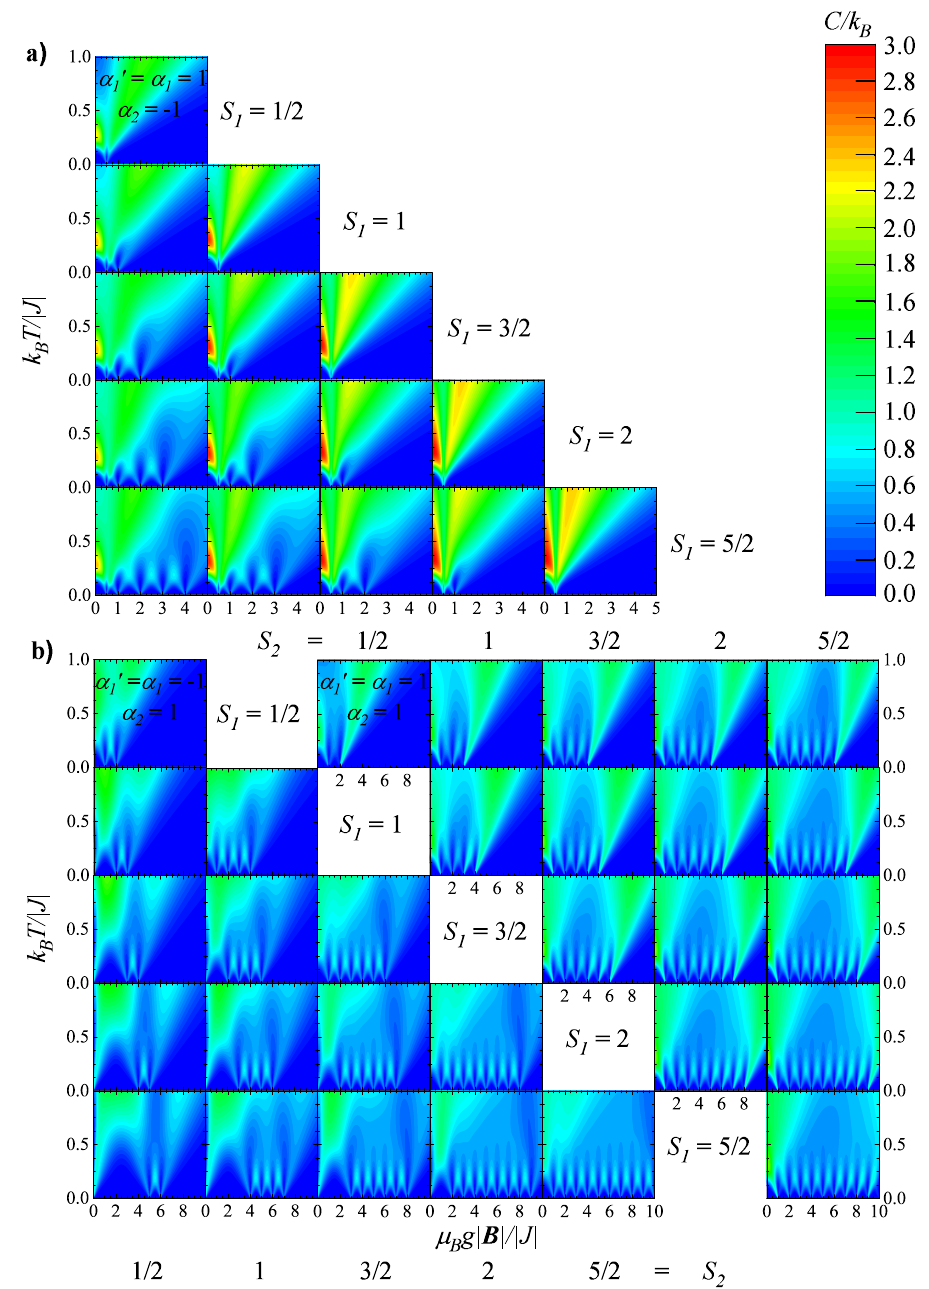
Figure 5. The heat capacity as a function of k B T / | J | and µ B g | B | / | J | . The scale bar on the top right side shows the value of heat capacity (in arbitrary units) for both diagrams. S 1 and S 2 denote the spin values of the constituents of dimer one and dimer two, respectively. J is assumed to equal 1. = α = 1 and α = − 1; ( b ) The heat capacity plots for ( a ) The heat capacity plots for the case of α (cid:48) 2 1 1 = α = α = 1 (top right) and α (cid:48) = α = − 1 and α = 1 (bottom left). Due to the the case of α (cid:48) 2 2 1 1 1 1 symmetry of the system, only half of the plots are shown for each